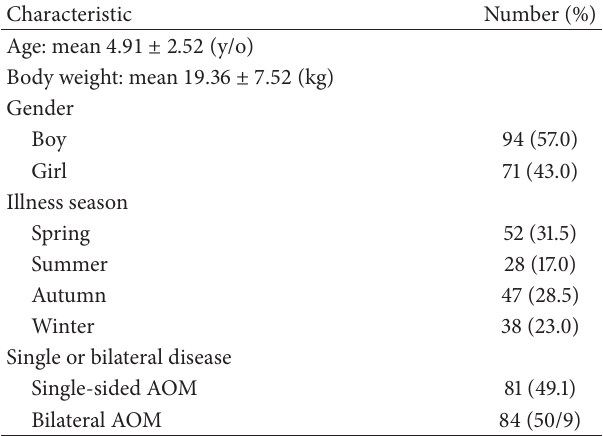
Table 1: Demographic data of 165 children.